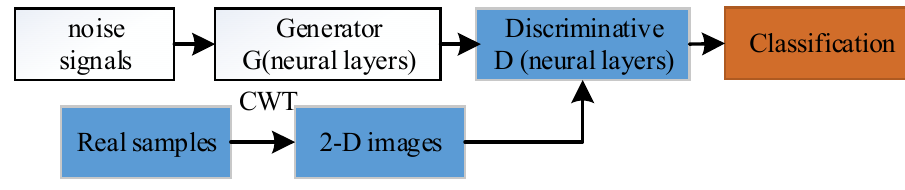
Figure 2. The architecture of the proposed method.